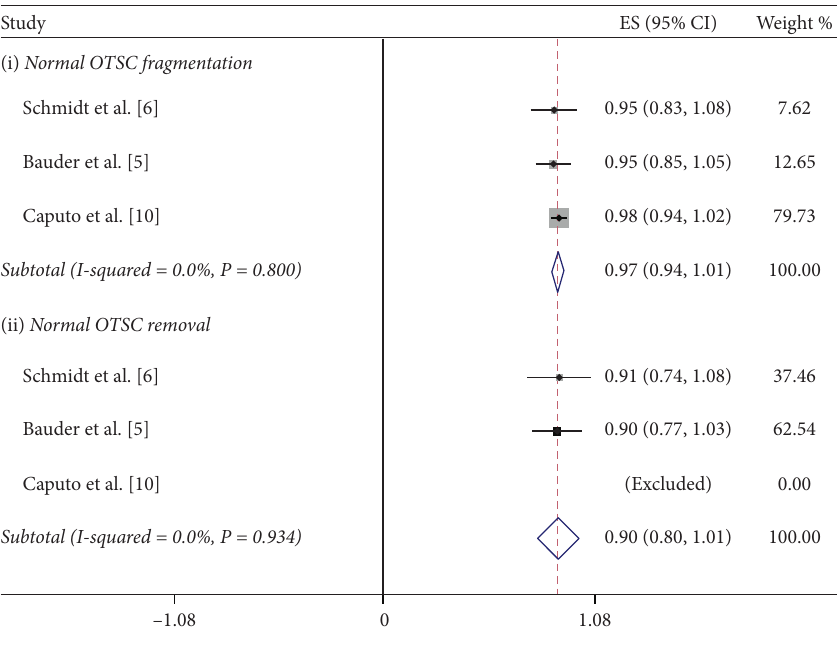
Figure 5: The subgroup analysis of success rate for normal OTSC removal by the remOVE